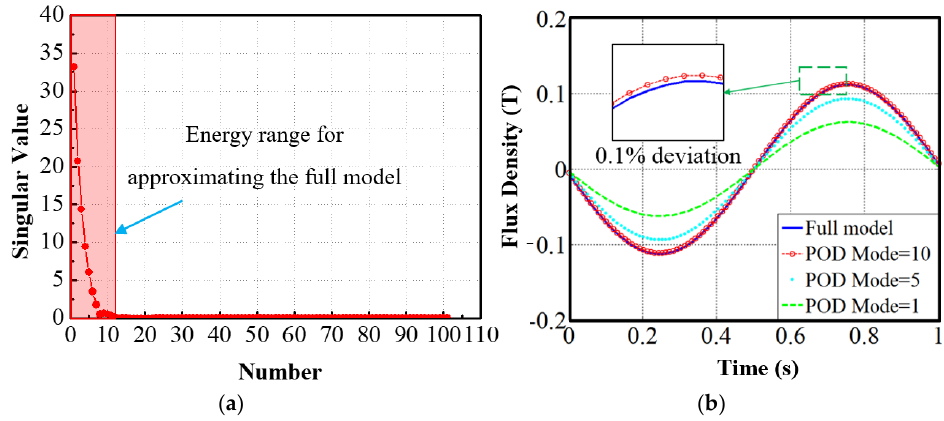
Figure 7. ( a ) Singular value spectrum of the snapshot matrix and ( b ) flux density distribution plot for the full model and reduced models with different POD modes.